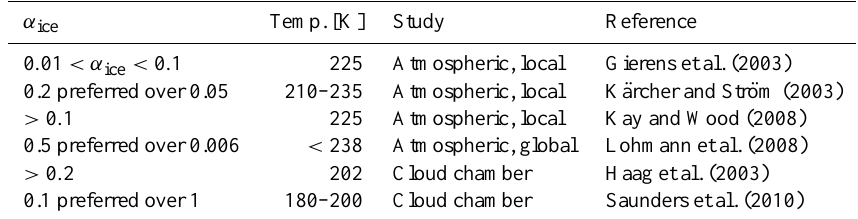
Table 2. Overview of cirrus cloud model studies with their preferred values or ranges for the accommodation coefficient α ice . Studies include the examination of atmospheric cirrus clouds and of simulated cirrus clouds in cloud chamber